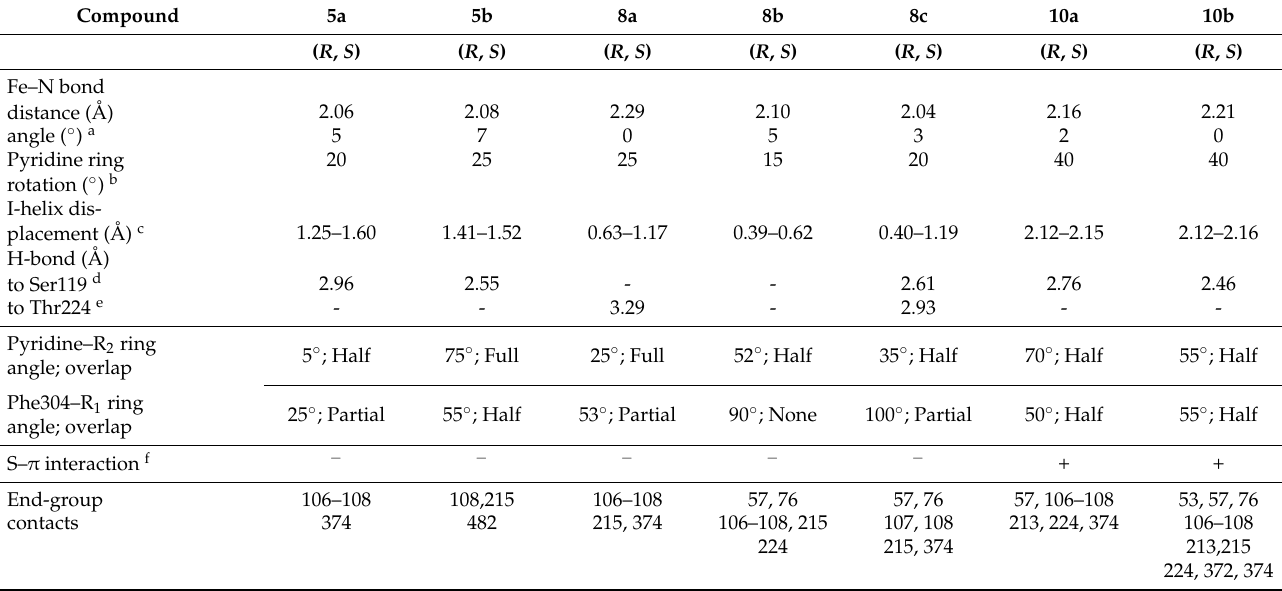
Table 3. Structural features of the inhibitory